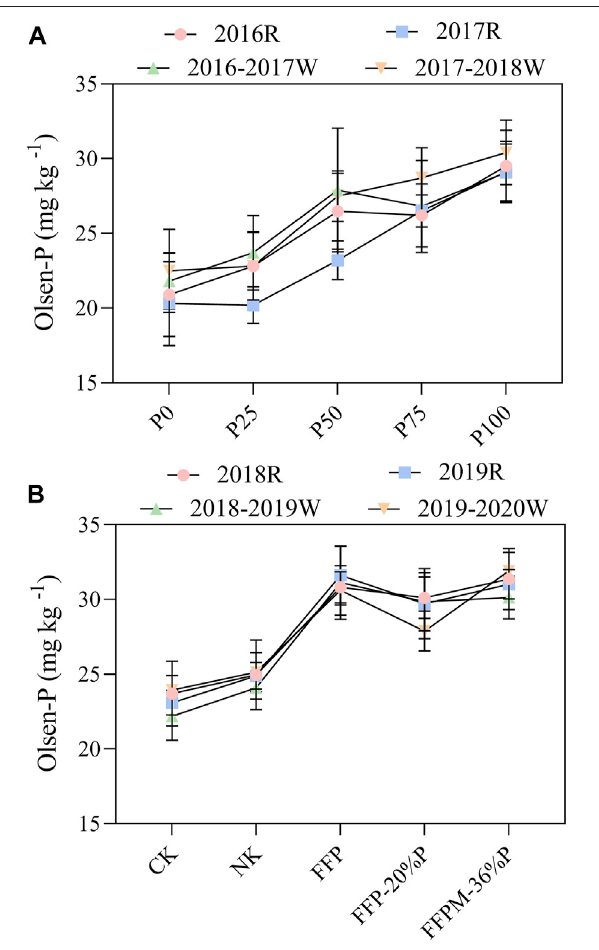
FIGURE 5 | Total P (TP) concentration under P fertilizer input and optimization on four-year rice-wheat rotation paddy fi eld from 2016 to 2020. FIGURE 6 | Olsen-P concentration under P fertilizer input and optimization on four-year rice-wheat rotation paddy fi eld from 2016 to 2020.